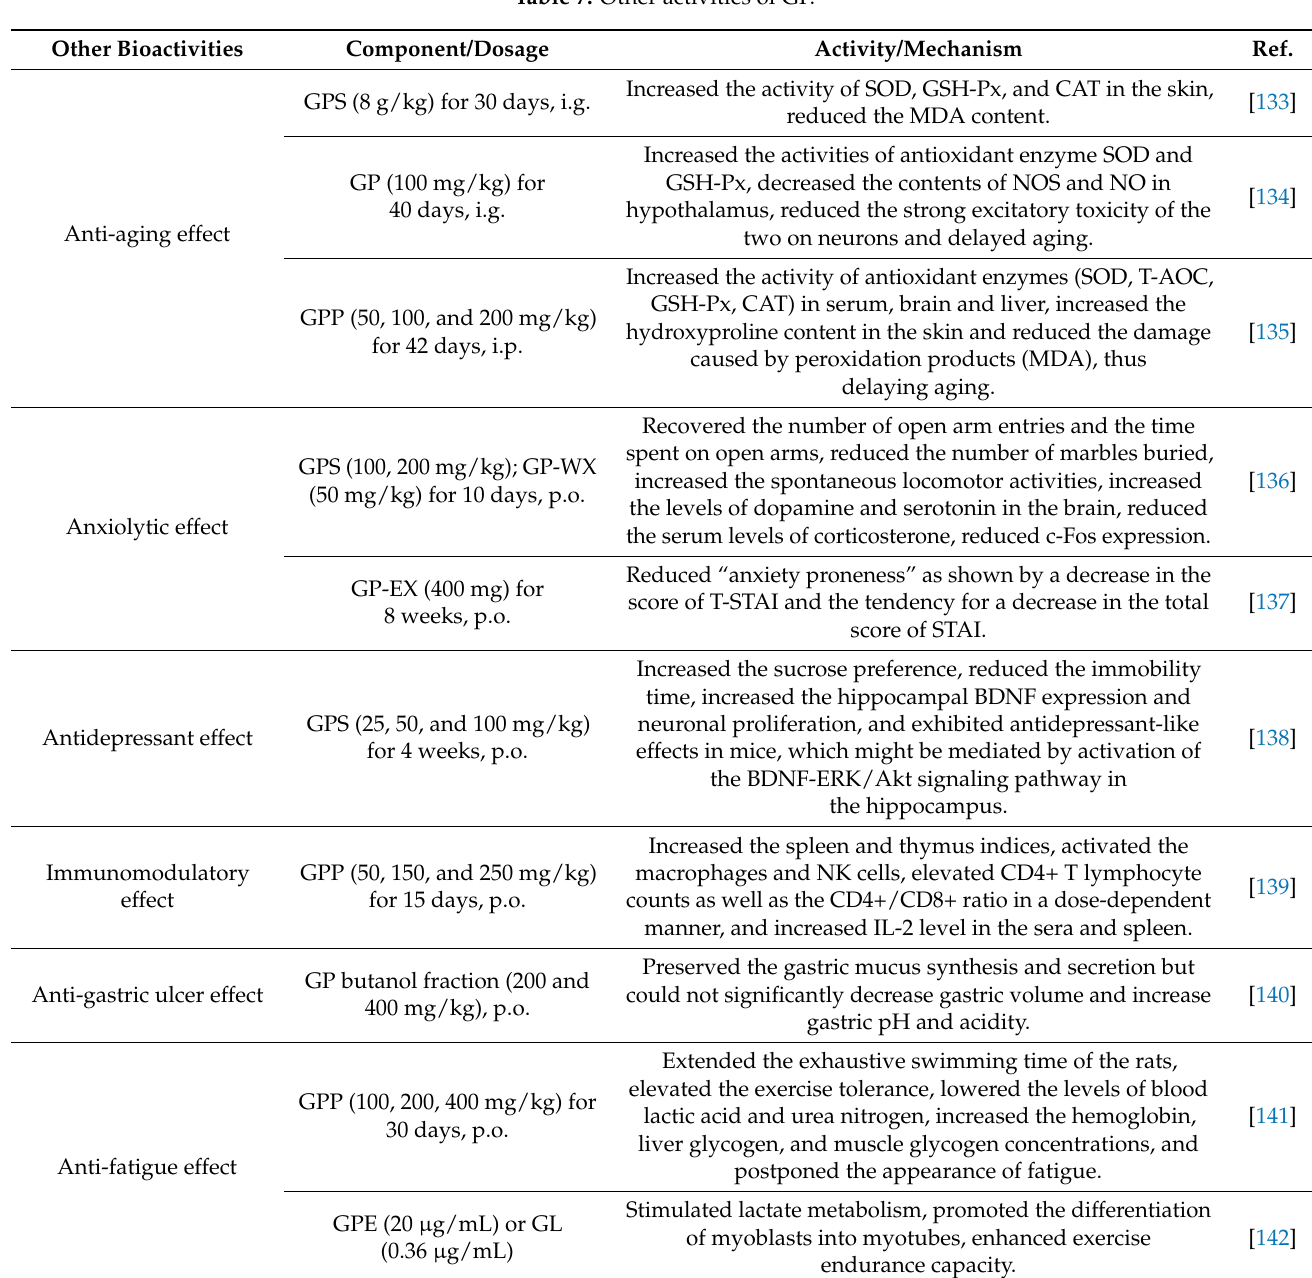
Table 7. Other activities of